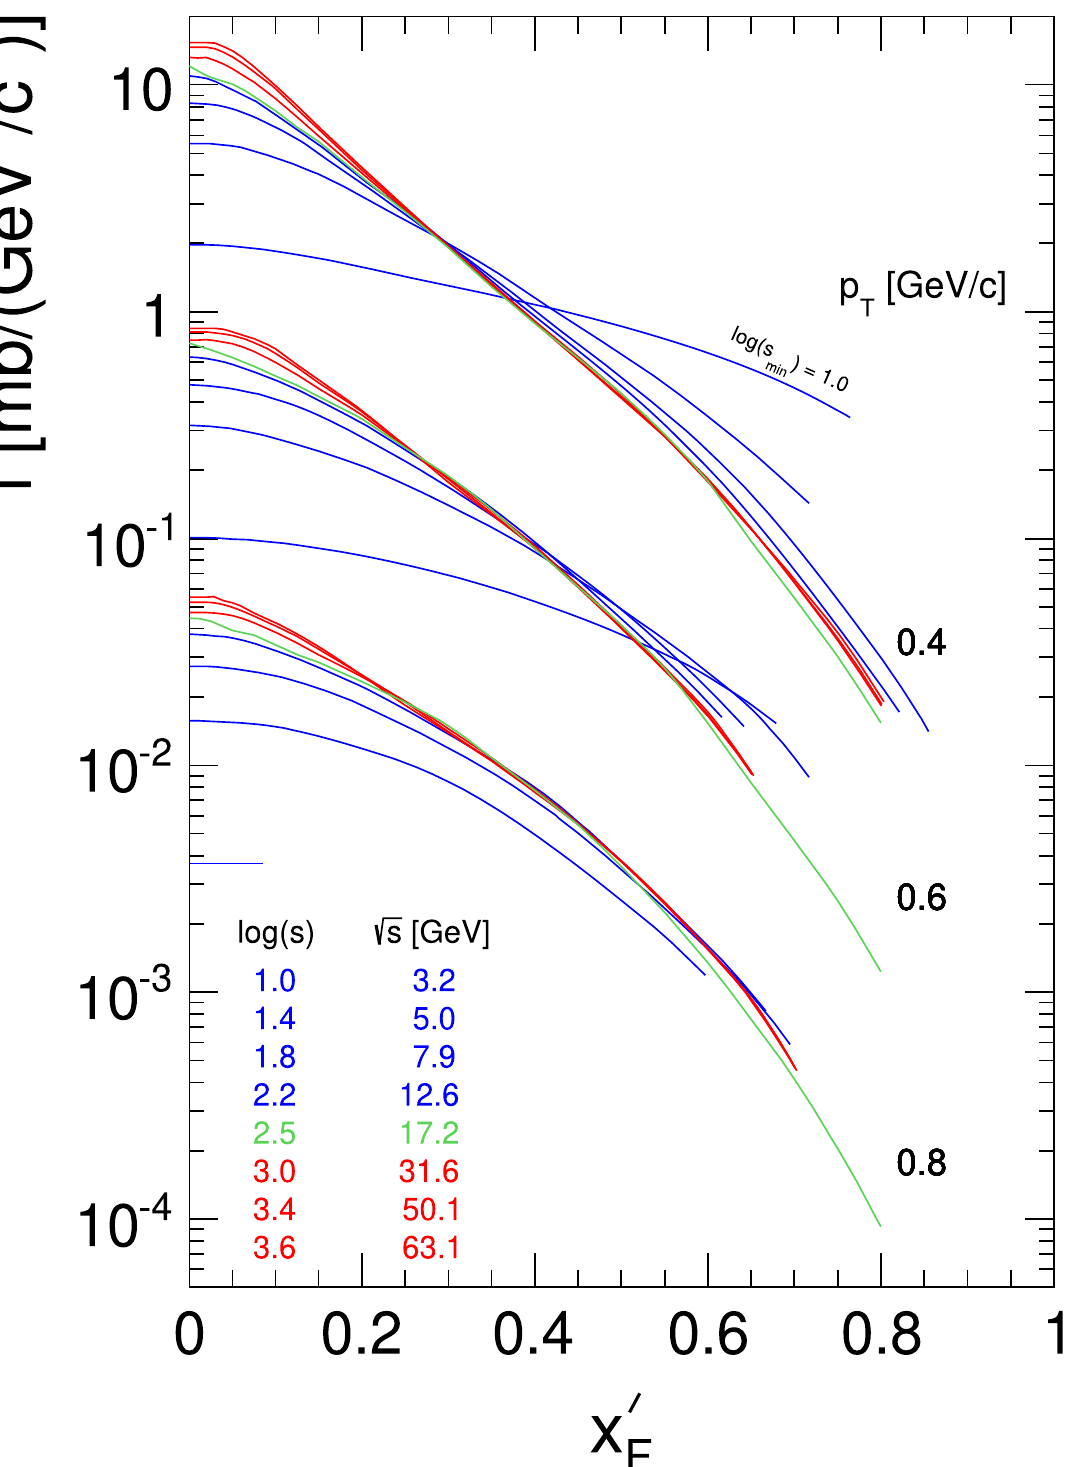
, p ) as a function of x (cid:3) Fig. 118 f ( x (cid:3) for p T = 0.4, 0.6 and 0.8 GeV/c for the global interpolation at log ( s ) values from 1.0 to 3.6. The plots at T F F subsequent p T values are scaled down by 1/5 for better separation. The NA49 interpolation at log ( s ) = 2.48 is shown as a green